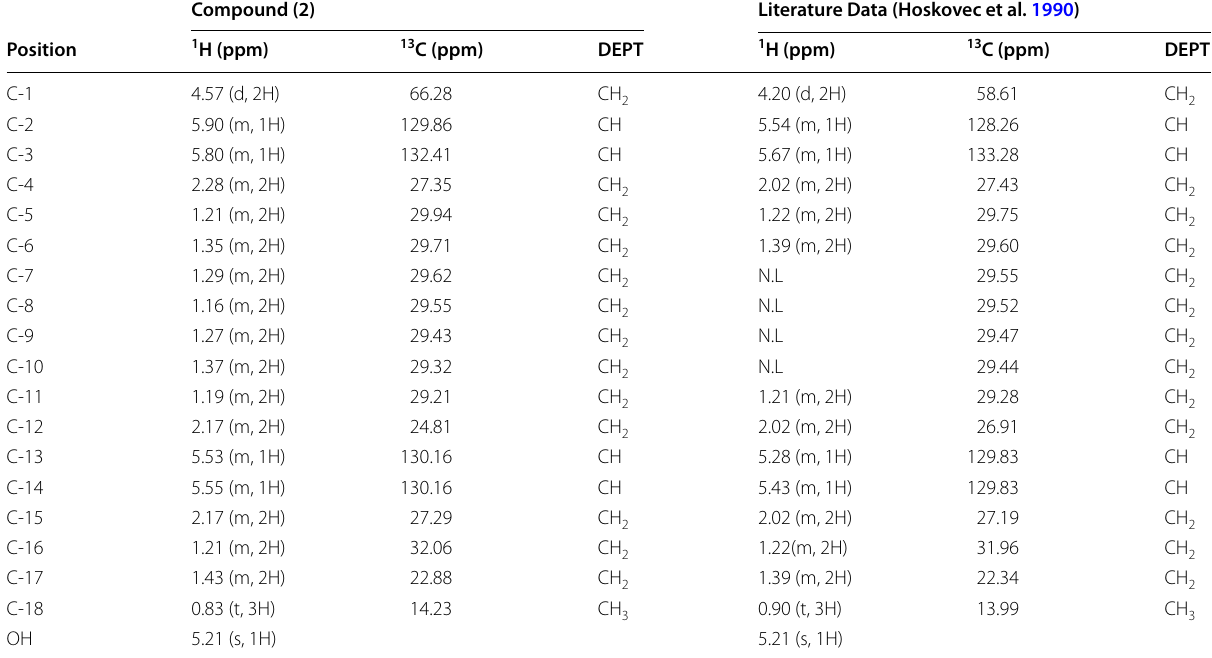
Table 2 The NMR (400 MHz) data of the compound (2) Compound (2) Literature Data (Hoskovec et al.